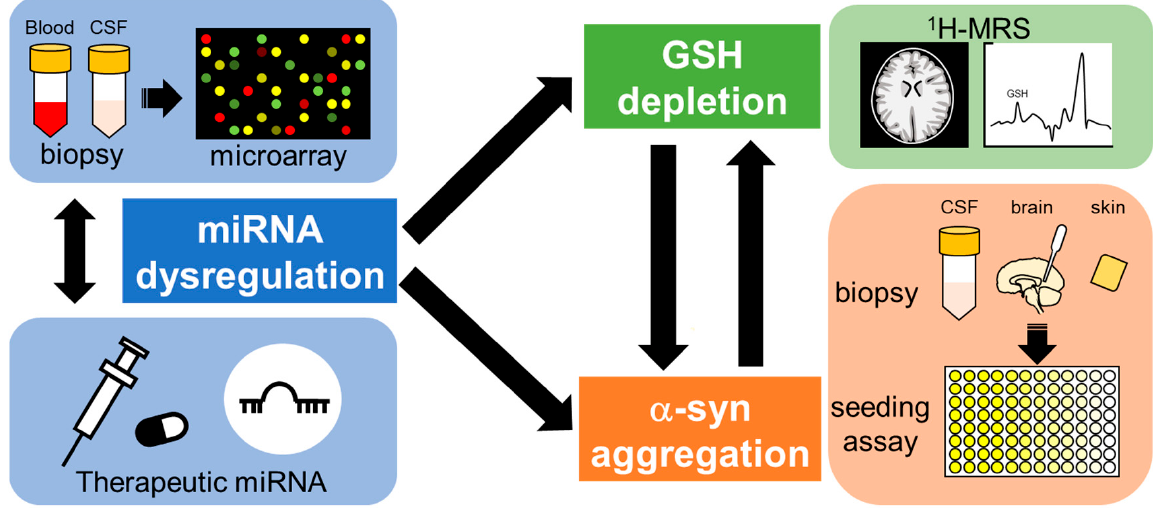
Figure 5. Strategies for early diagnosis and treatment of MSA.